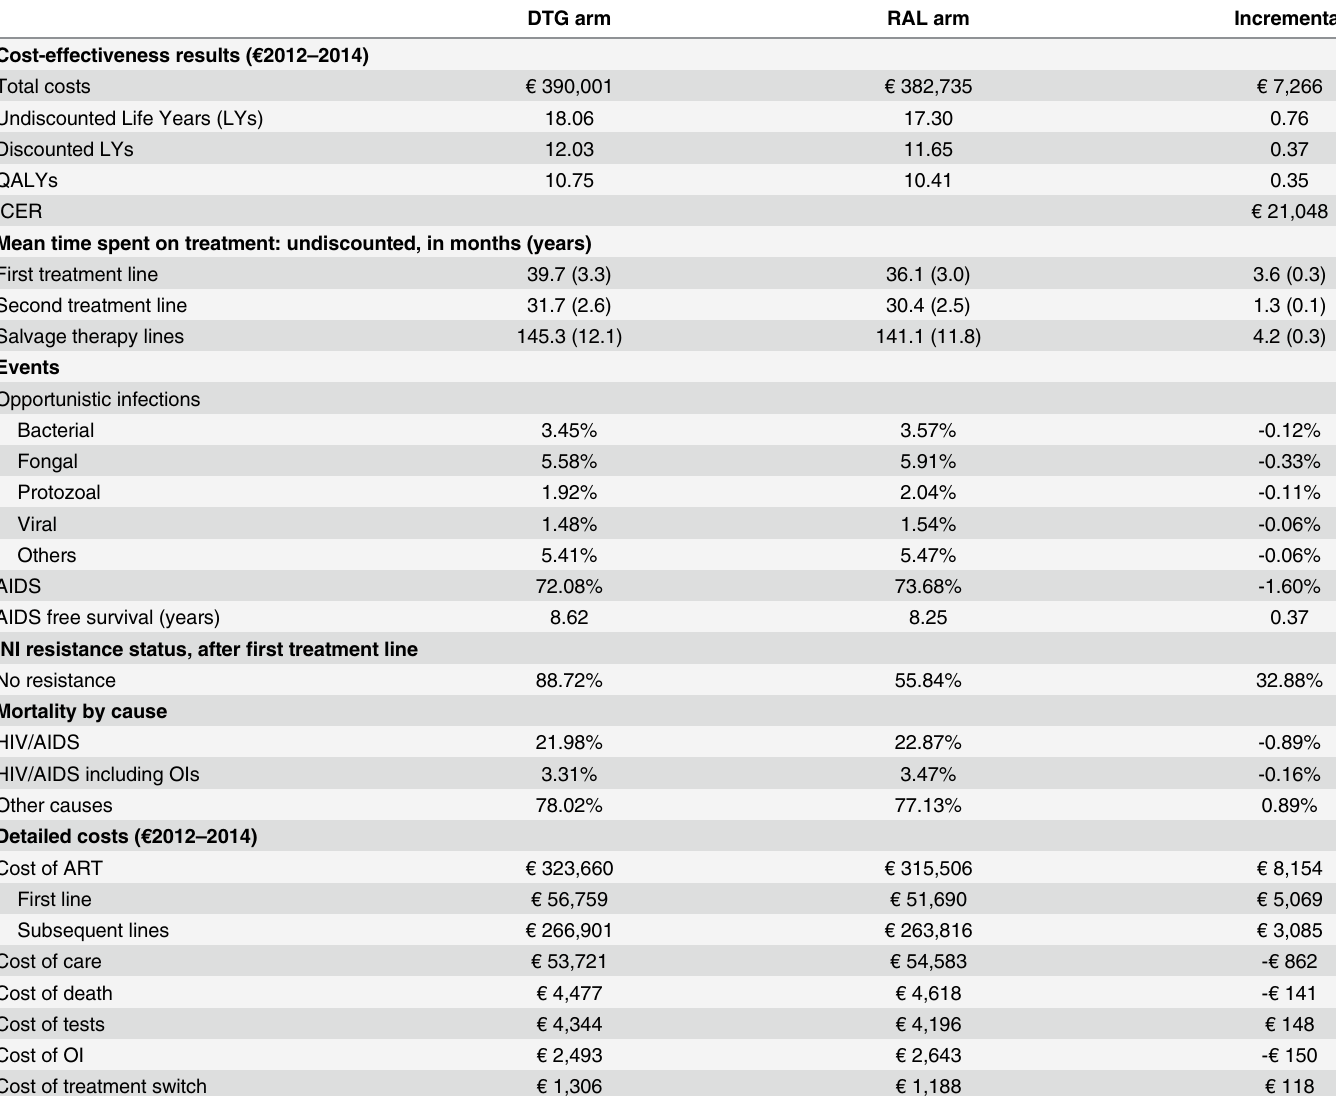
Table 4. Base-case results.